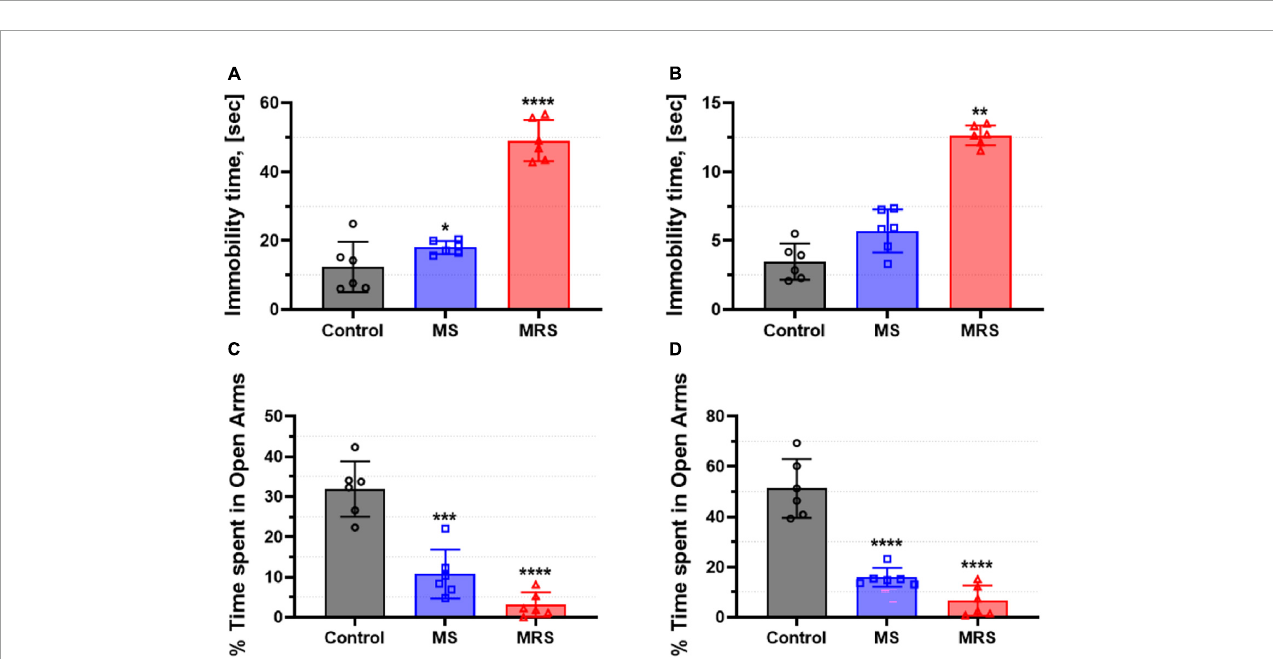
FIGURE3 Comparison of immobility time in the forced swim test [ (A) male and (B) female] and % time spent in open arms in the elevated plus-maze [ (C) male and (D) female]. Data are presented as means ± SD ( n = 6). Statistical significance was defined as a p -value less than 0.05 (* p < 0.05, ** p < 0.01, *** p < 0.001, **** p <